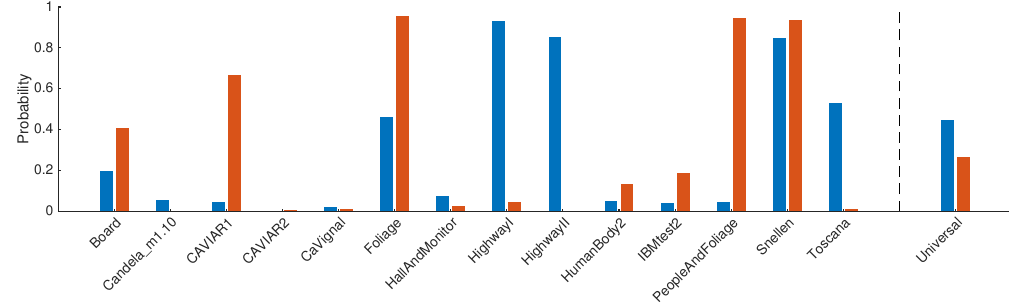
Figure 6. Probabilities P ( G = fg | O = o i ) with O = car (cid:4) , and O = plant (cid:4) , obtained using the CV scene-specific estimators for each sequence of the SBI dataset and the CV universal estimators applied on the universal training dataset (see Section